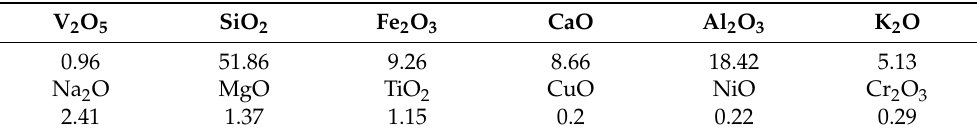
Figure 1. X-ray diffraction (XRD) diffractogram of vanadium ore. Table 1. Main chemical components of the vanadium ore